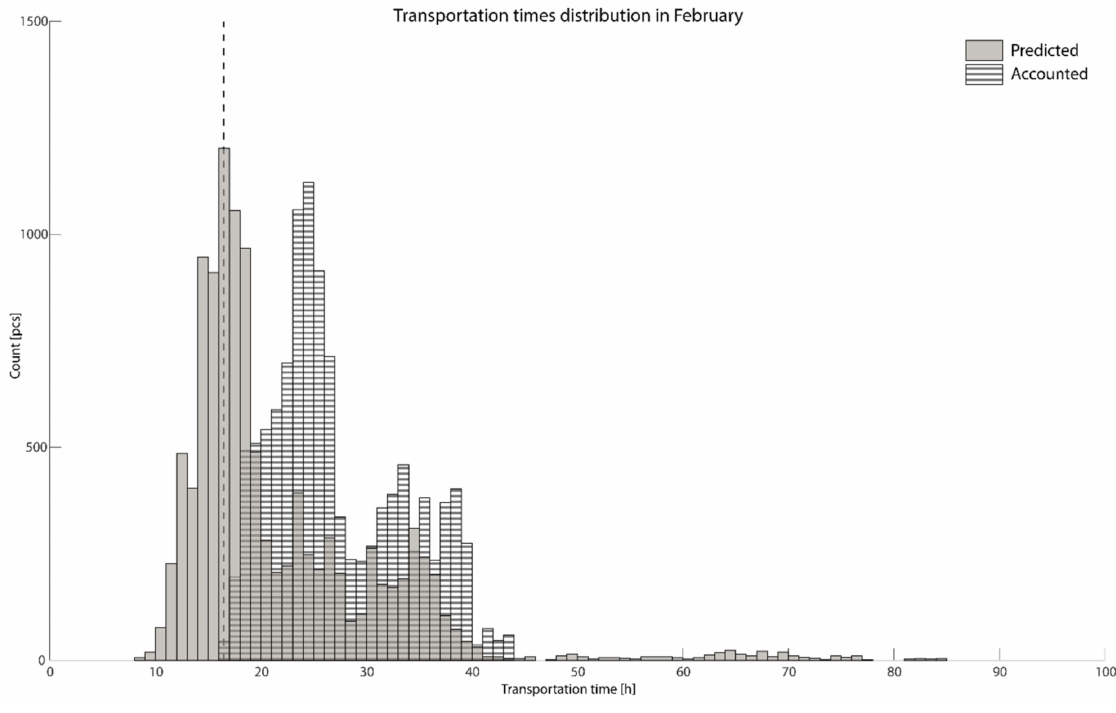
Figure 11. Distribution of the transportation times. The dashed line is the calculated average, grey represents the predicted times, and striped represents the accounted transportation times in